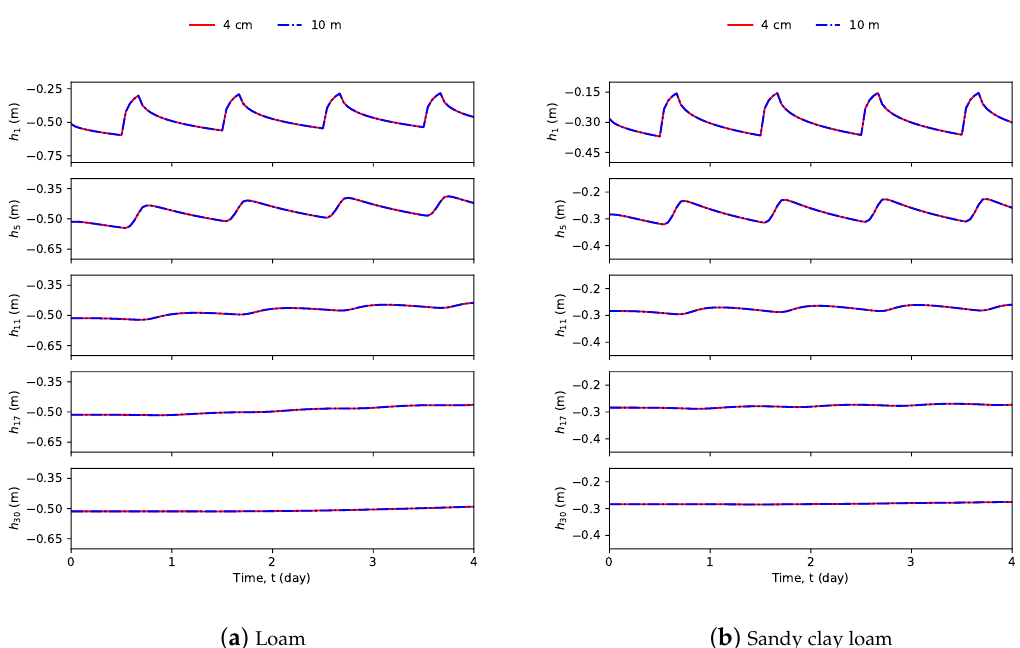
Figure A1. Comparison of selected trajectories of Model 1 (4 cm) and Model 2 (10 m) under Scenario 1.